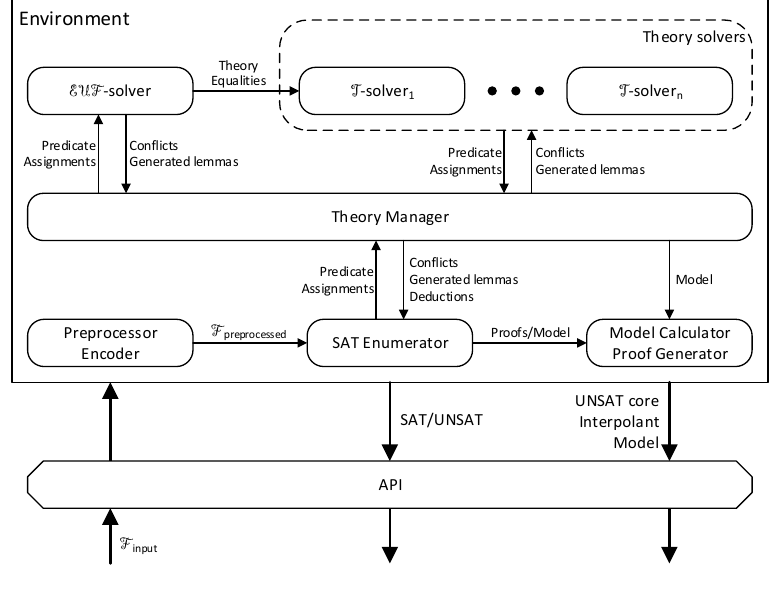
Figure 7. MathSAT5’s internal architecture